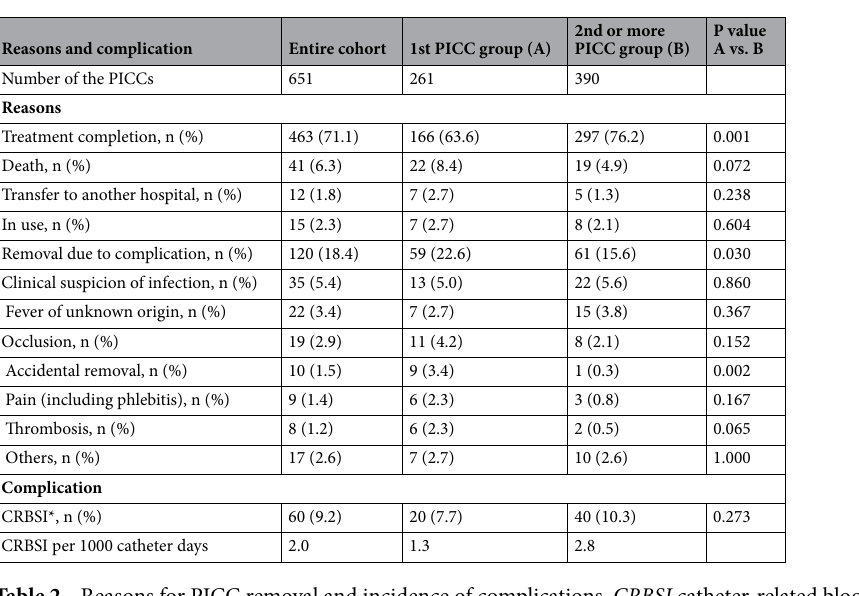
Table 2. Reasons for PICC removal and incidence of complications. CRBSI catheter-related bloodstream infection, PICC peripherally inserted central catheter. *Even after detection of CRBSI, some patients continued treatment without removal of the PICC, depending on the pathogenic bacteria, patient condition, and responses to antimicrobial agents.